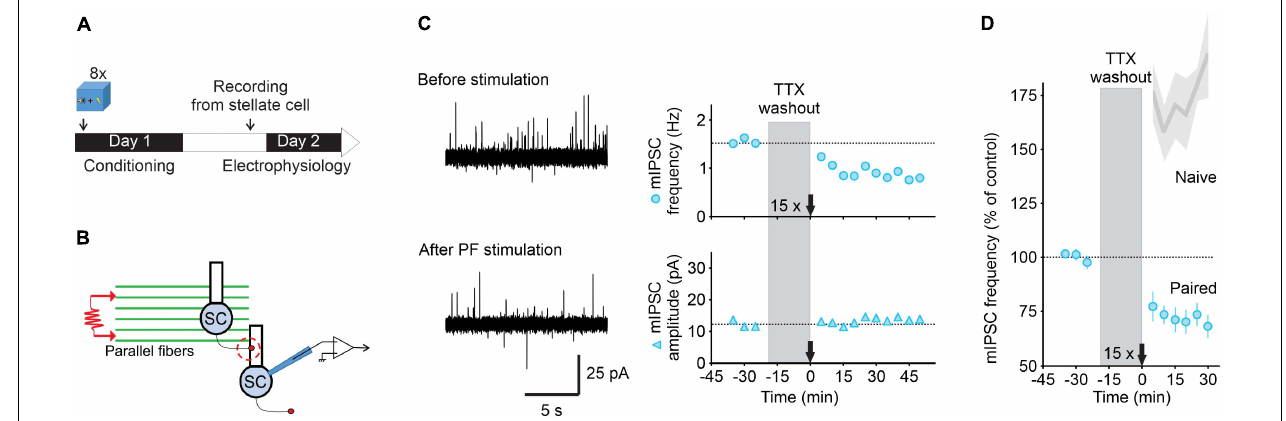
FIGURE 2 | Parallel fiber stimulation triggers a long-lasting decrease in GABA release after fear learning. (A) Fear conditioning protocol for electrophysiology experiments. (B) Schematic of the experimental procedure. (C) Left, representative traces of mIPSCs recorded in a stellate cell at -30 mV (outward currents) before (top) and after (bottom) PF stimulation (15 trains of four pulses at 100 Hz). Right, corresponding time course of mIPSC frequency (top) and amplitude (bottom). (D) While this protocol triggered I-LTP in naïve wildtype animals [Shaded gray represent data from Dubois et al. (2016)], after fear conditioning burst activation of parallel fibers induced I-LTD stim ( n = 5). Values are mean ± SEM. Statistical analysis values can be found in the Supplementary Table 1